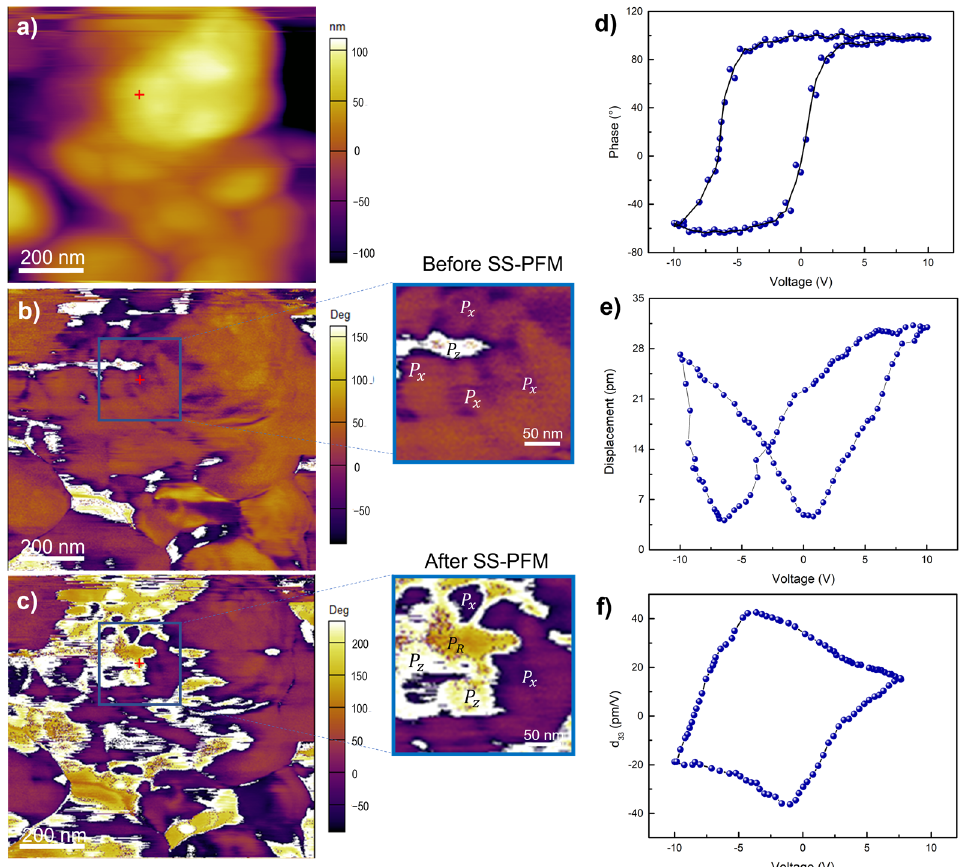
Figure 1. ( a ) Topography in contact mode of WO 3 thin film annealed at 400 °C. PFM phase signal images ( b ) before and ( c ) after measurement of the local hysteresis loops revealing variation of the structure of domains with different orientation of polarization; ( d ) amplitude, ( e ) phase, and ( f ) piezoelectric coefficient ( d 33 ) versus applied bias.